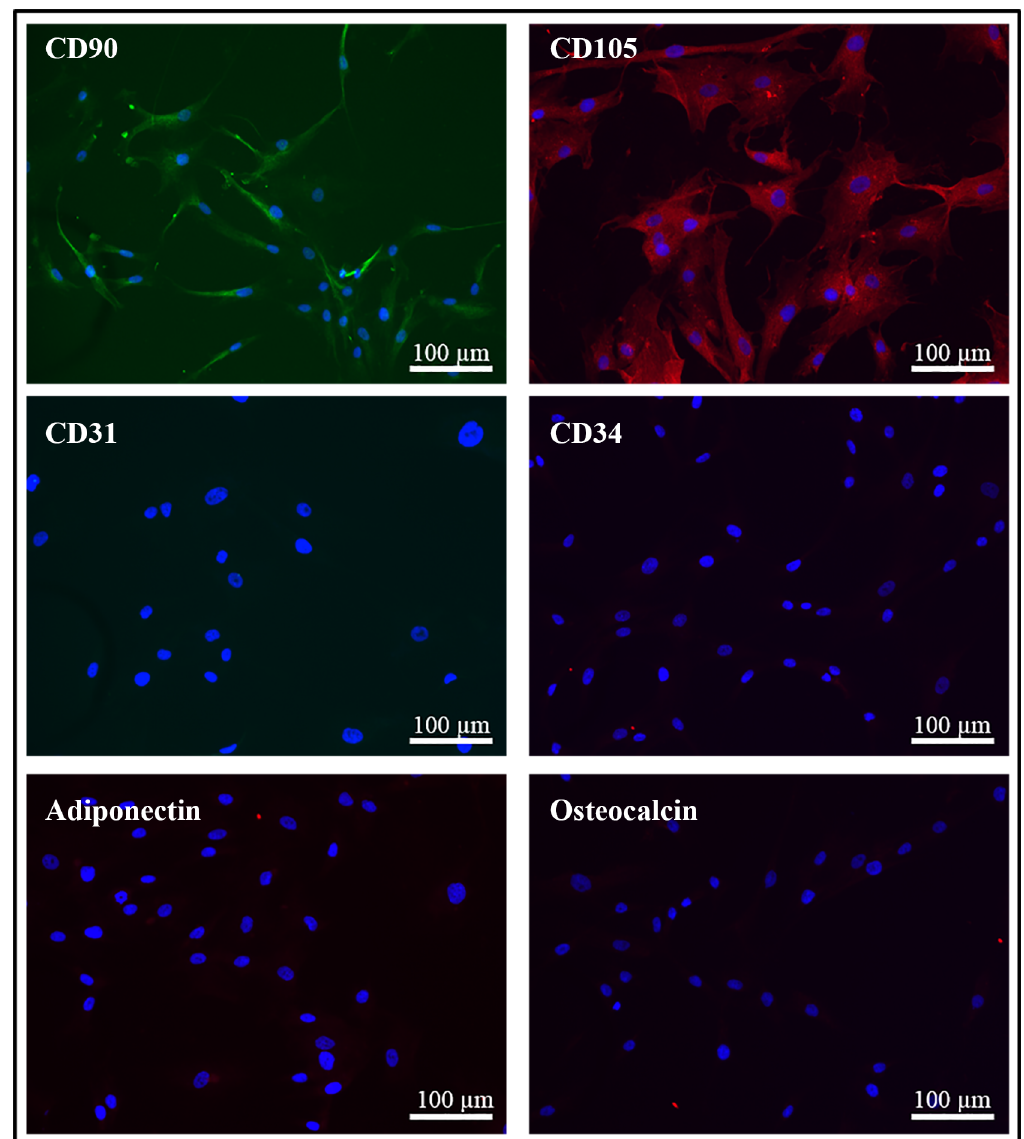
Fig 1. Characterization of primary ASCs. The expressionof CD90, CD105, CD31, CD34, adiponectin,and osteocalcinwas examinedby immunocytochemistry in the primary ASCs at passage4–6. Scale bar = 100 μ m.